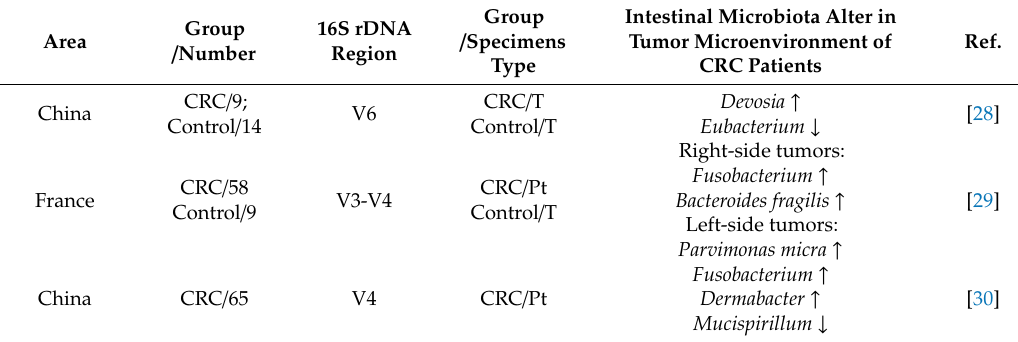
Table 1. Source of data for this